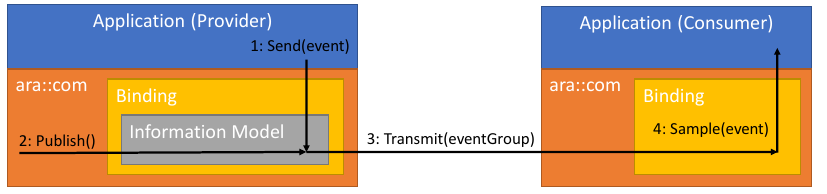
Figure 8. Transmission of an event from a provider to a